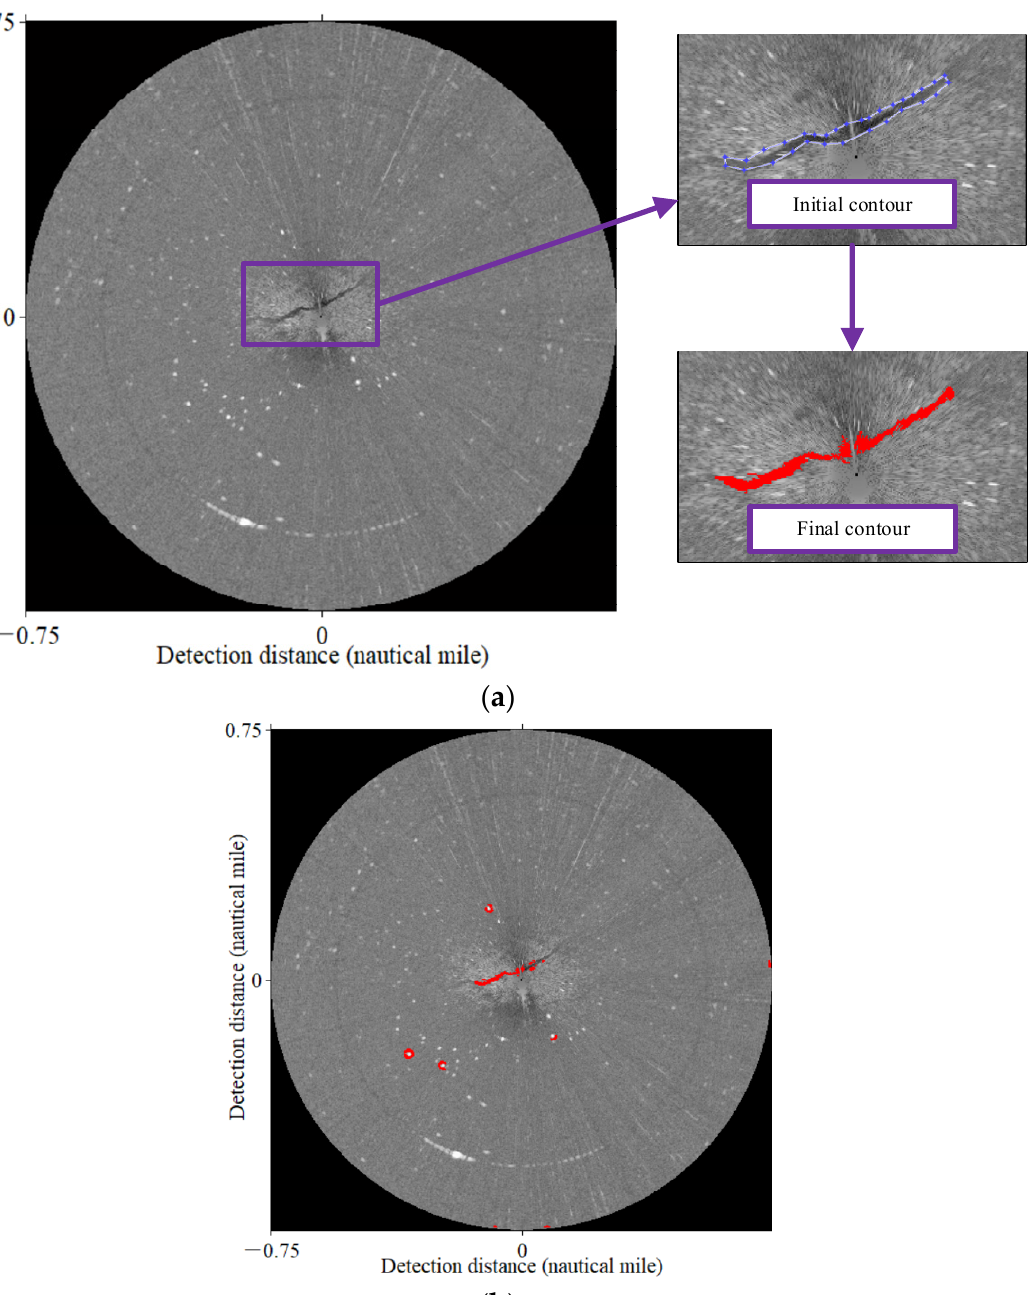
Figure 15. Results of Method 2. ( a ) Contour extraction after image sampling; ( b ) Contour extraction in the whole image. The segmentation results were marked in